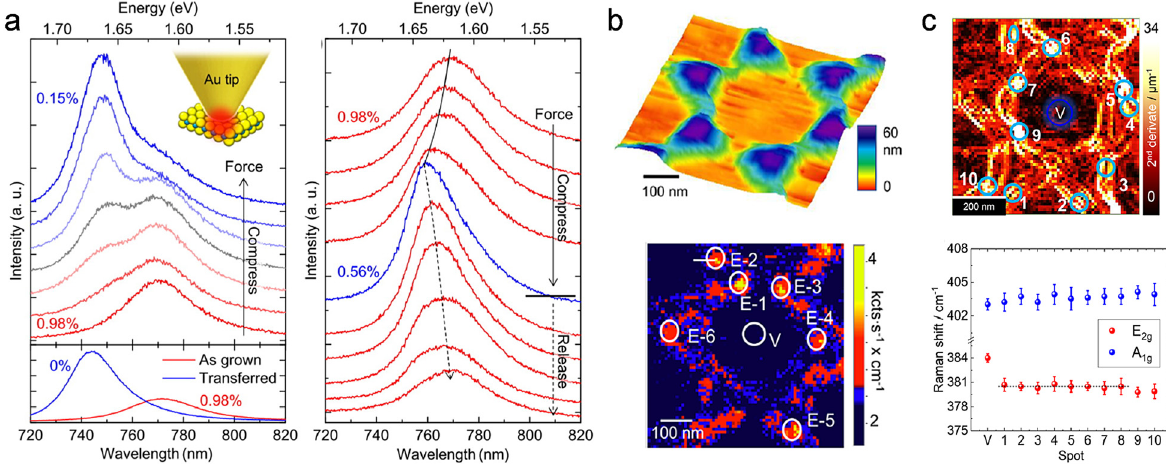
Figure 10: Strain controlled by artificial methods. (a) Left panel: TEPL spectra of 1L-WSe 2 with increasing compressive force induced by the tip (upper panel). For comparison, as-grown and transferred 1L-WSe 2 is presented (lower panel). Right panel: reversibly controllable TEPL spectra under control of the tip force. Reproduced with permission from ref. [36]. Copyright 2016, Nature Publishing Group. (b) AFM topography (upper) and TERS image (lower) (c) second order derivative image of AFM image (upper) and Raman peak position at the numbered locations indicated by circles (lower). Reproduced with permission from ref. [125].